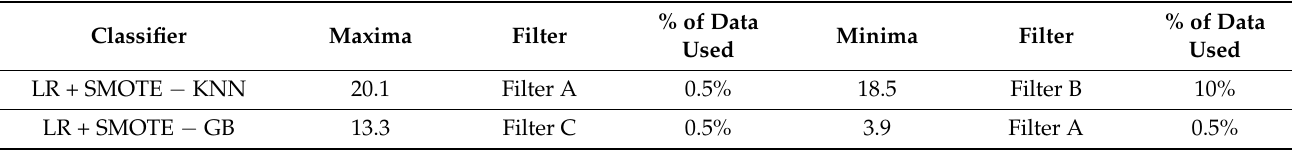
Table 4. Enrichment Ratios of OPRK1 on the original dataset with no feature selection with a training size of 30%.